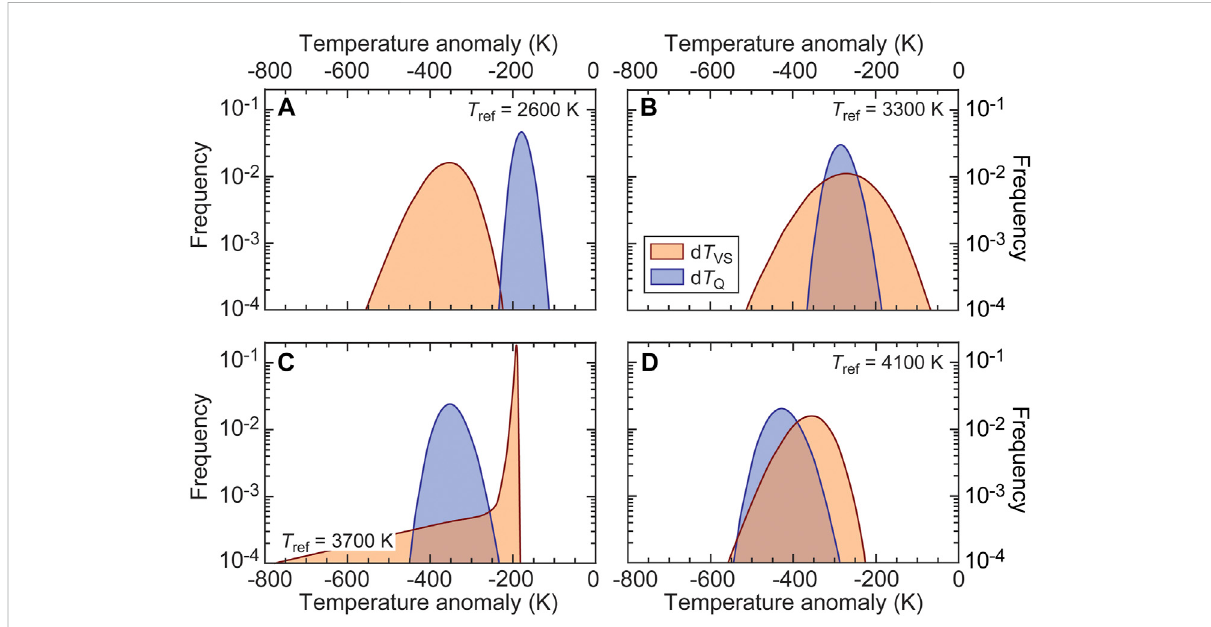
FIGURE 3 Probability density functions of temperature anomalies deduced from dln V S (d T VS , orange distributions) and Q S (d T Q , blue distributions) measured in corridor S2 beneath Central America (see Borgeaud and Deschamps 2021 for the exact location). Mean and standard deviation in dln V S and Q S are1.0%and0.1%and470and20,respectively(Table1),anddifferentreferencetemperature T ref areconsideredineachplot:2600K (A) ;300 K (B) ;3700 K (C) ;and4100K (D) .Othermodeling parametersare setto theirpreferred values listedinTable 2.Theoverlap between thepdfsfor d T VS and d T Q at a speci fi c value of T ref is taken as a measure of the probability p that T ref is equal to this speci fi c value. The transition temperature to post-perovskite is set to T pPv = 3500 K. Note that the frequency ( y -axis) is plotted in logarithmic